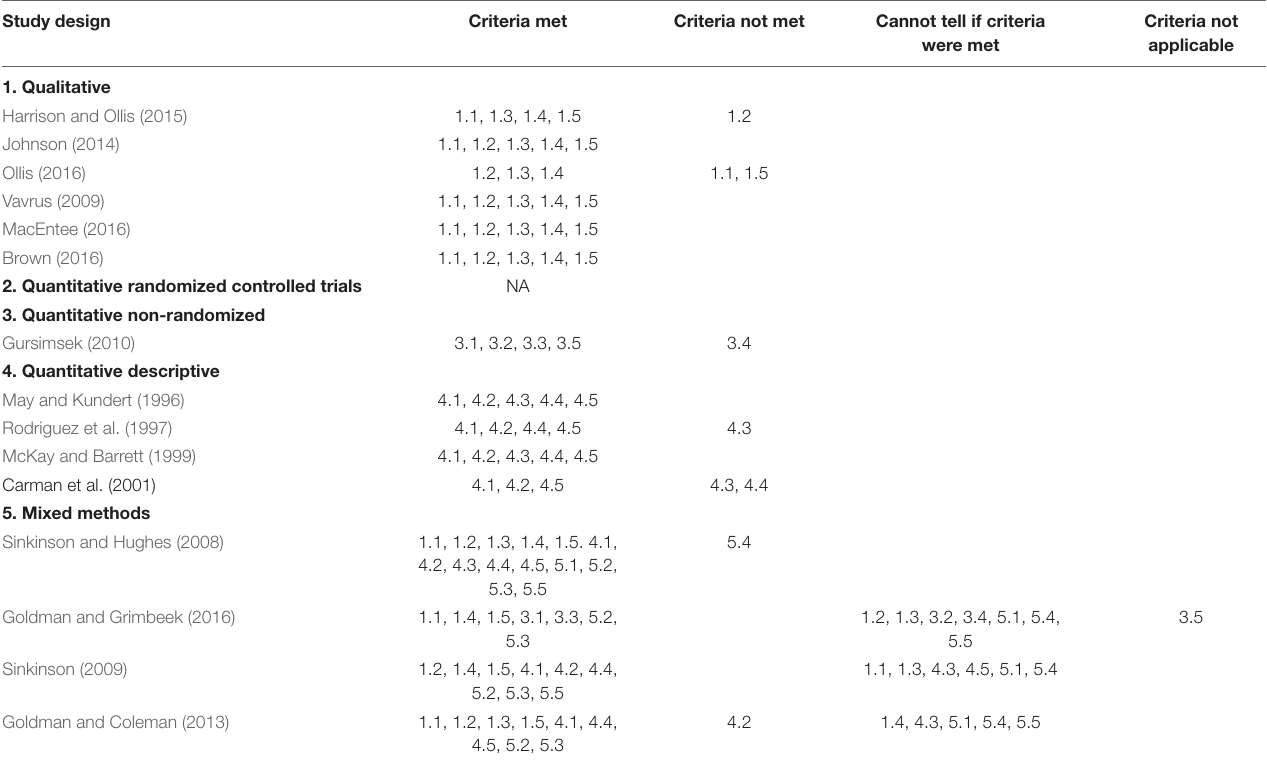
TABLE 4 | MMAT quality appraisal.* Study design Criteria